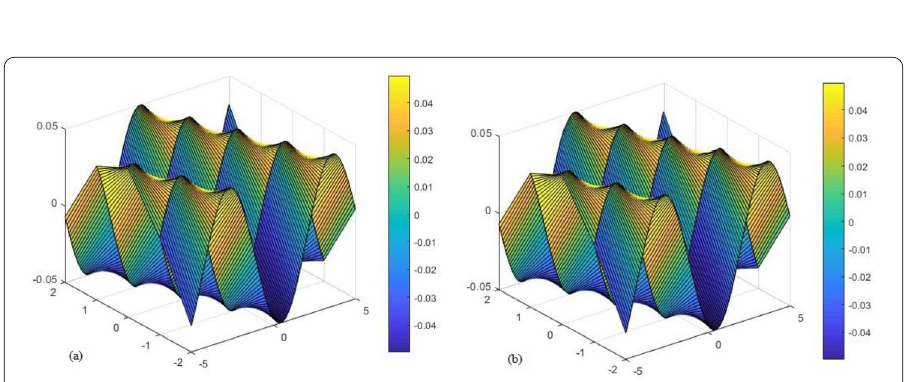
Figure 4 The graph of exact ( a ) and approximate ( b ) solution of (cid:13) ( χ , ϕ , η ) at ϒ = 1 of Example 1